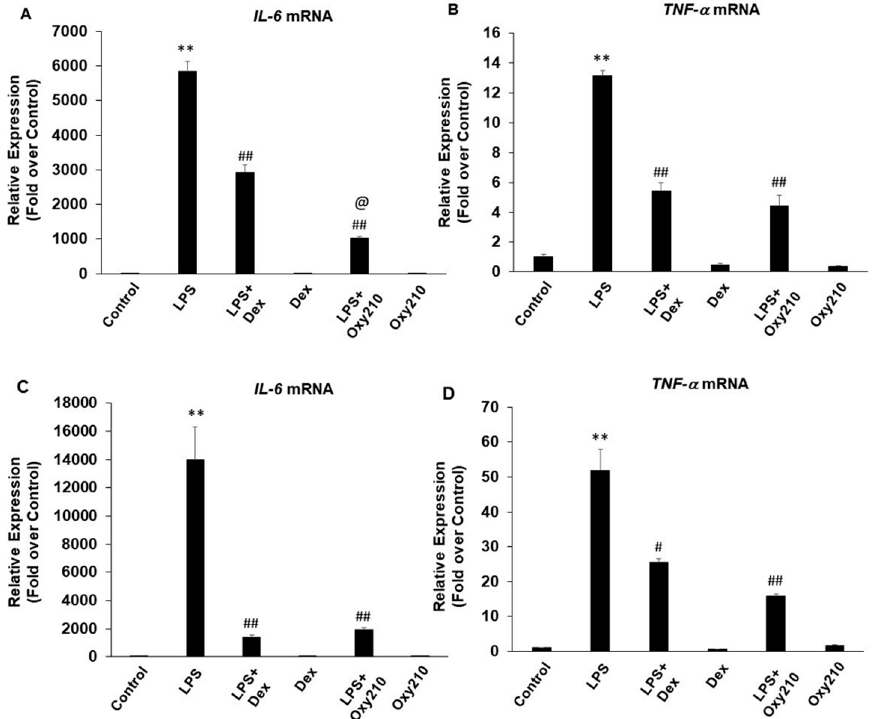
Figure 7. Inhibition of LPS-induced inflammatory gene expression in RAW264.7 macrophages by dexamethasone and Oxy210. ( A , B ) RAW264.7 cells were pretreated with Oxy210 (5 μ M) or